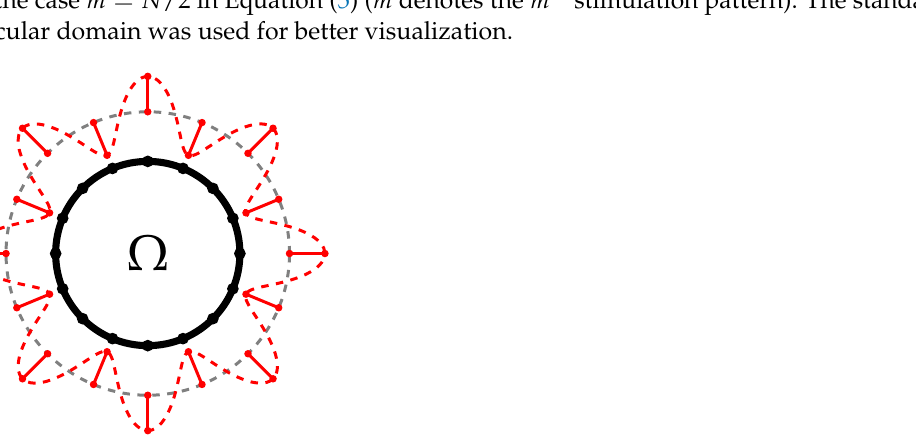
Figure 1. Visualization of one stimulation pattern. Ω surrounded by the thick black circle denotes the domain of interest. The red line indicates the current depending on the angle Θ . The dashed gray line denotes a current amplitude of zero. Note that this is not the domain used in this paper, but a standard circular domain for better visualization of the